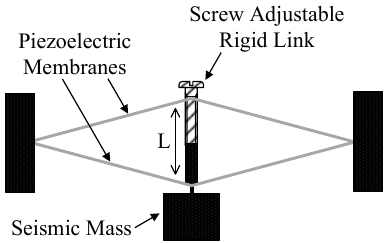
Figure 15. Schematic representation of the axial loads based MTT proposed in [31].